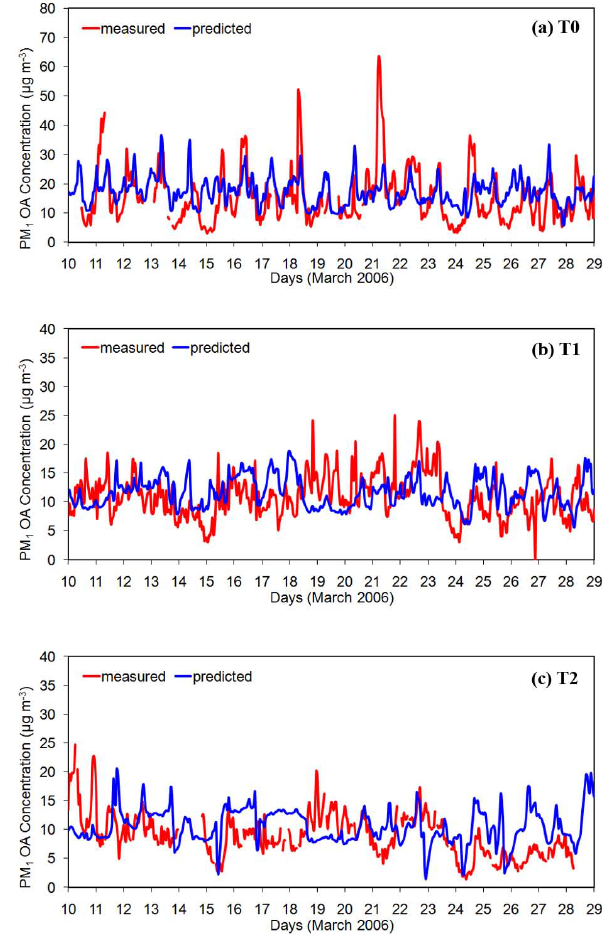
Fig. 4. Comparison of model predictions with hourly measurements for total PM 1 organic mass concentration taken during the MILA- GRO campaign in March 2006 at (a) T0 (urban site), (b) T1 (sub- urban site), and (c) T2 (rural site).